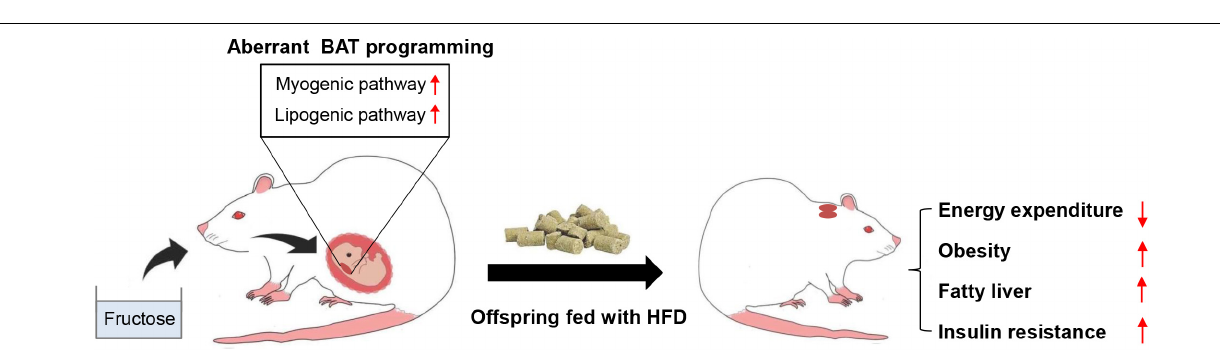
FIGURE 7 | A model depicting the effects of maternal high-fructose feeding on offspring BAT development and metabolic health. Maternal high-fructose feeding during gestation reprograms brown fat lineage specification, especially exhibiting activated myogenic pathway and lipogenic pathway, which probably results in the impairment of HFD-induced energy expenditure and the predisposition of HFD-induced obesity, fatty liver, and insulin resistance in adult offspring. * p < 0.05, ** p < 0.01, *** p <